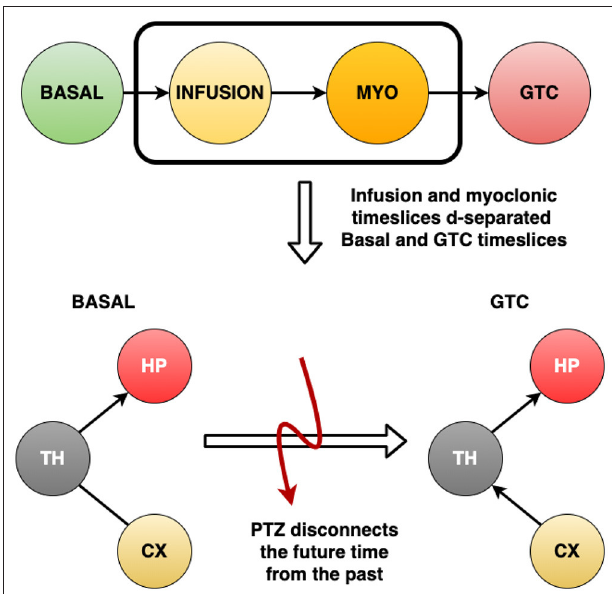
FIGURE 7 | The four time slices used to develop the (Dynamic) Bayesian Network for each rat: Basal, Infusion, MYO and GTCS. After building the networks, it was observed that the Basal interval do not help to explain what happens during GTCS period. Also, it was verified that Infusion and MYO time slices connect them. This means that the infusion of PTZ drug disconnects time slices, which reveals that it is a different process occuring since the beginning of drug